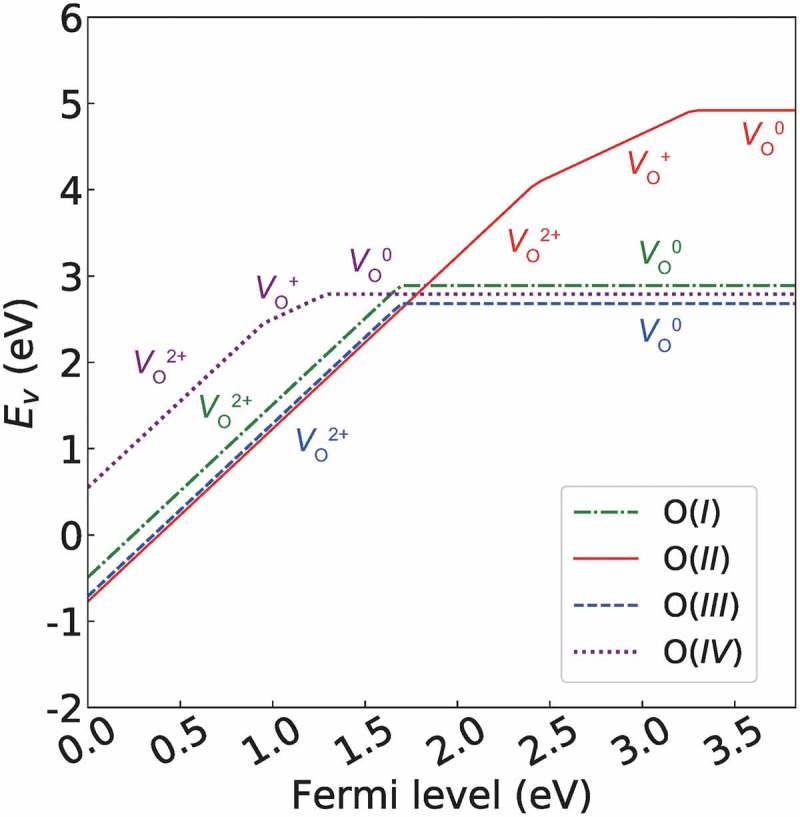

Ev as a function of Fermi level of La3GaO6. μ
O is set to be ½E(O2) − 1.75 eV to describe the pressure and temperature at 1 atm and 1500 K, respectively. The other Ln3GaO6 (Ln = Nd, Gd, Tb, Dy, Ho, Er, or Lu) series showed a similar trend (see Supplementary Figures S3). The gradient of the lines denotes the charge of the defect.